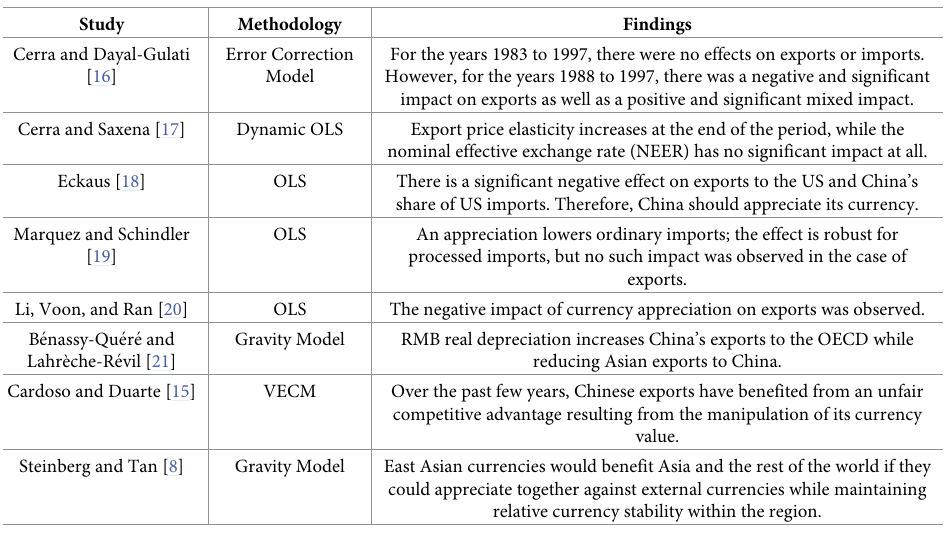
Table 4. Literature on China exchange rate and